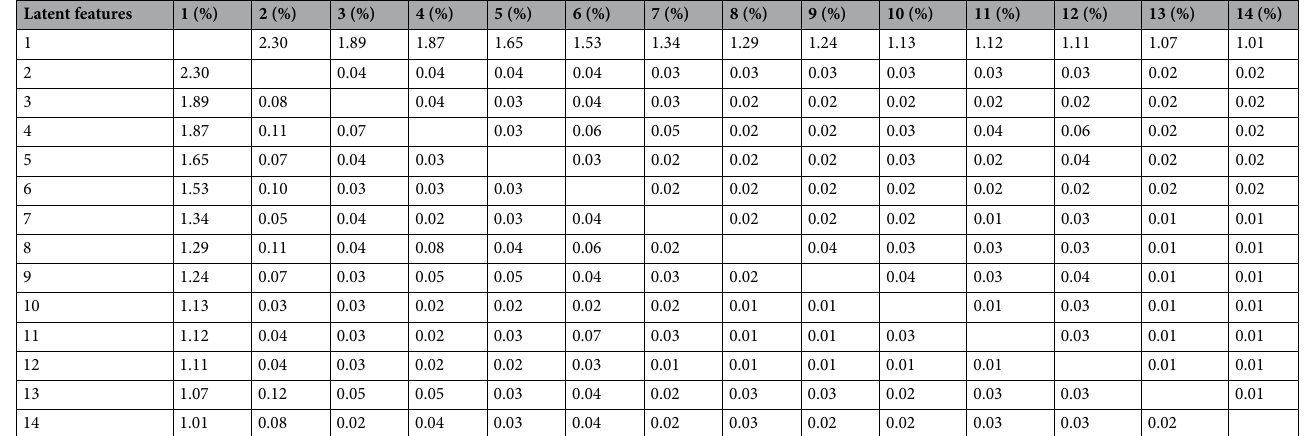
Table 4. Probabilities of possessing at least two latent features. Empirical probabilities were directly extracted from the observed latent matrix. Product probabilities were calculated from the individual latent feature probabilities, as reported in Table 3. The elements below the diagonal correspond to the empirical probability, and the elements above the diagonal correspond to the product